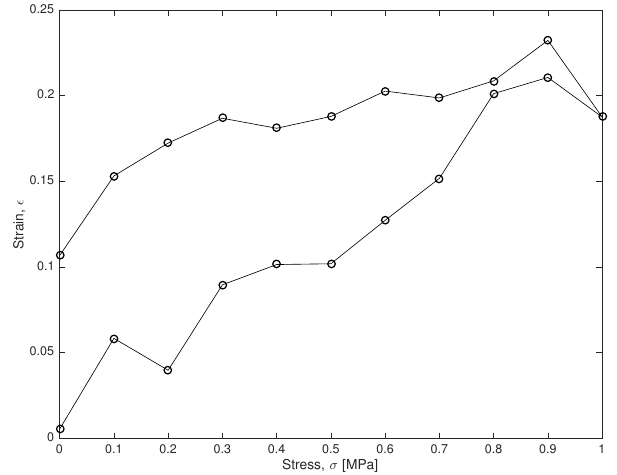
Figure 3. Example of stress control test. Each circle stands for a recorded measurement. The lower branch is the loading curve, whereas the upper one is the unloading